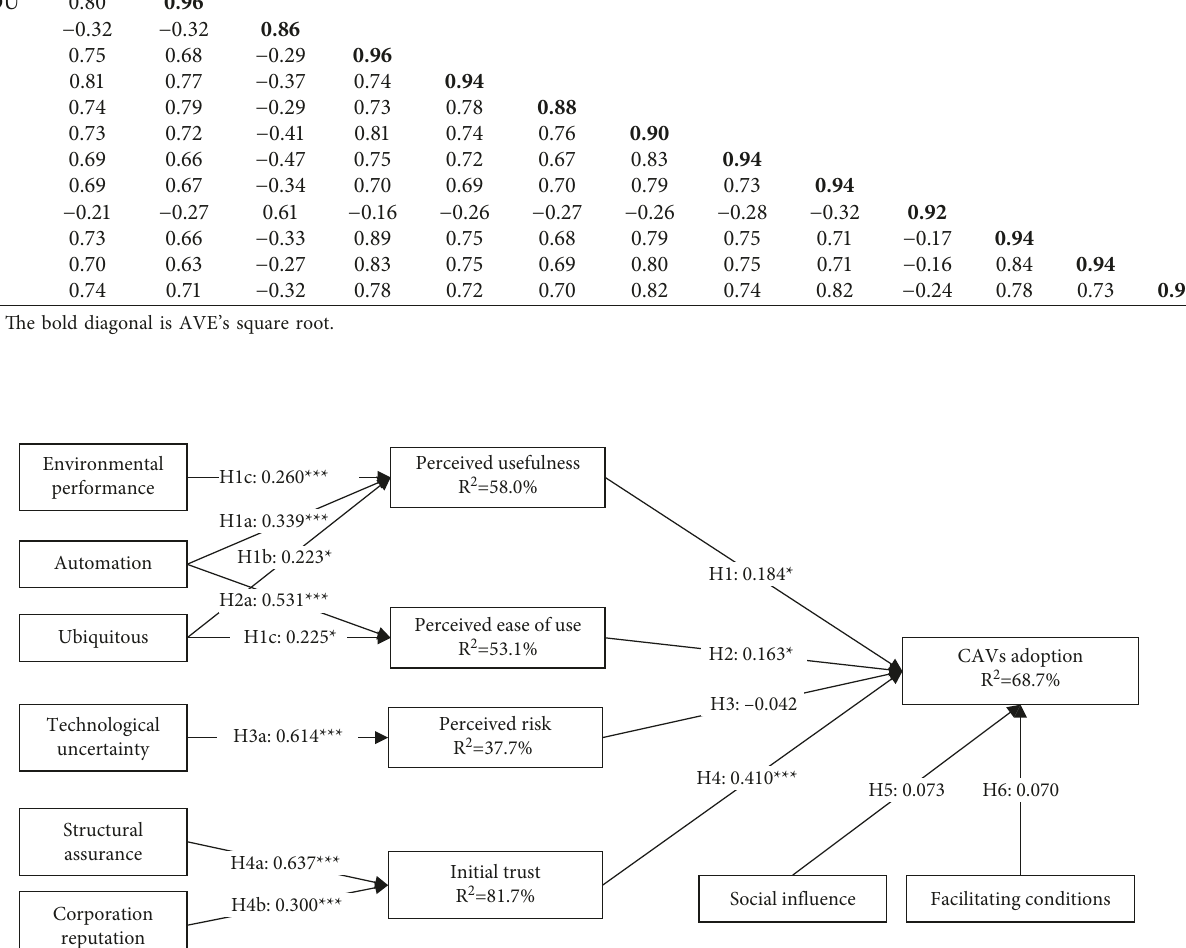
Figure 2: The results of the structural model of CAVs adoption. Note. ∗ p < 0.05; ∗∗ p < 0.01; ∗∗∗ p <